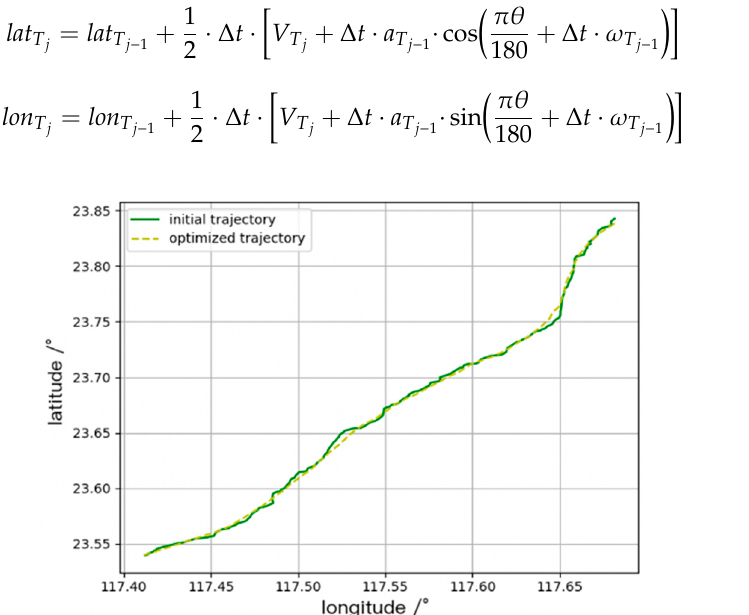
Figure 5. Plot of the comparison of the original trajectory and optimized trajectory of a same vessel.